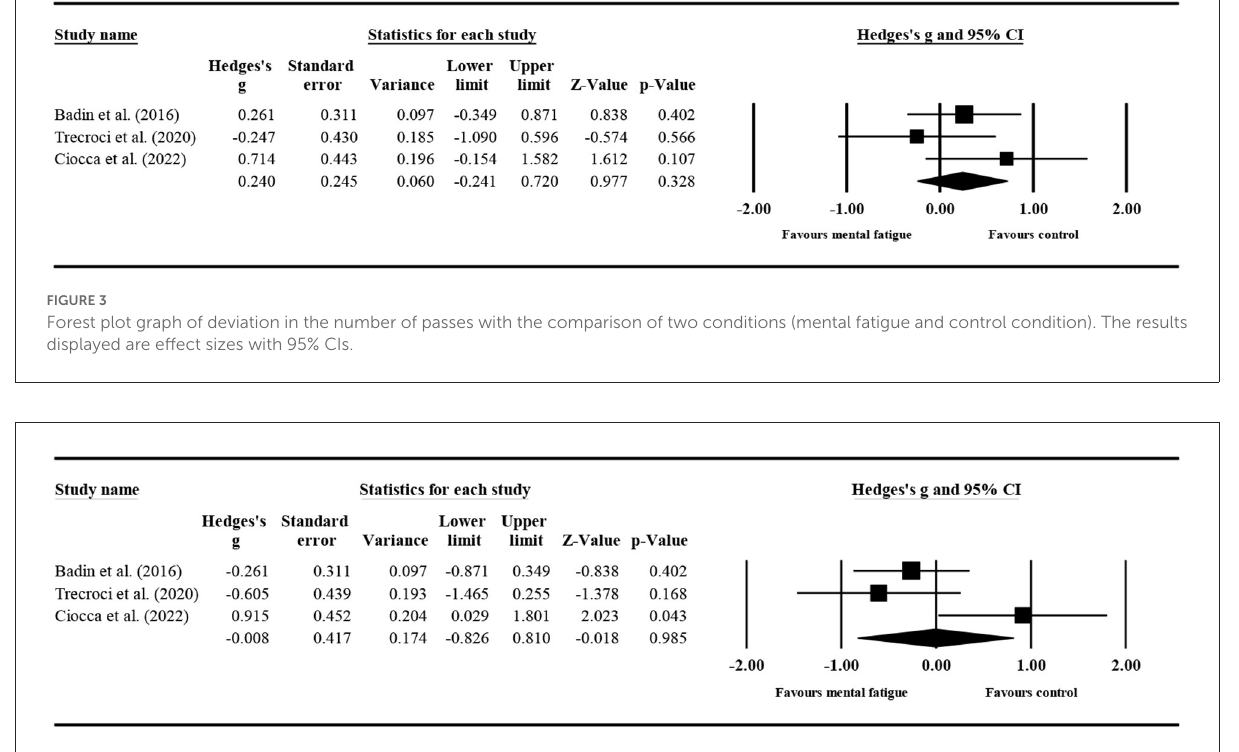
FIGURE4 Forest plot of changes in the percentage of accurate passing with the comparison of two conditions (mental fatigue and control condition). The results displayed are effect sizes with 95% CIs.